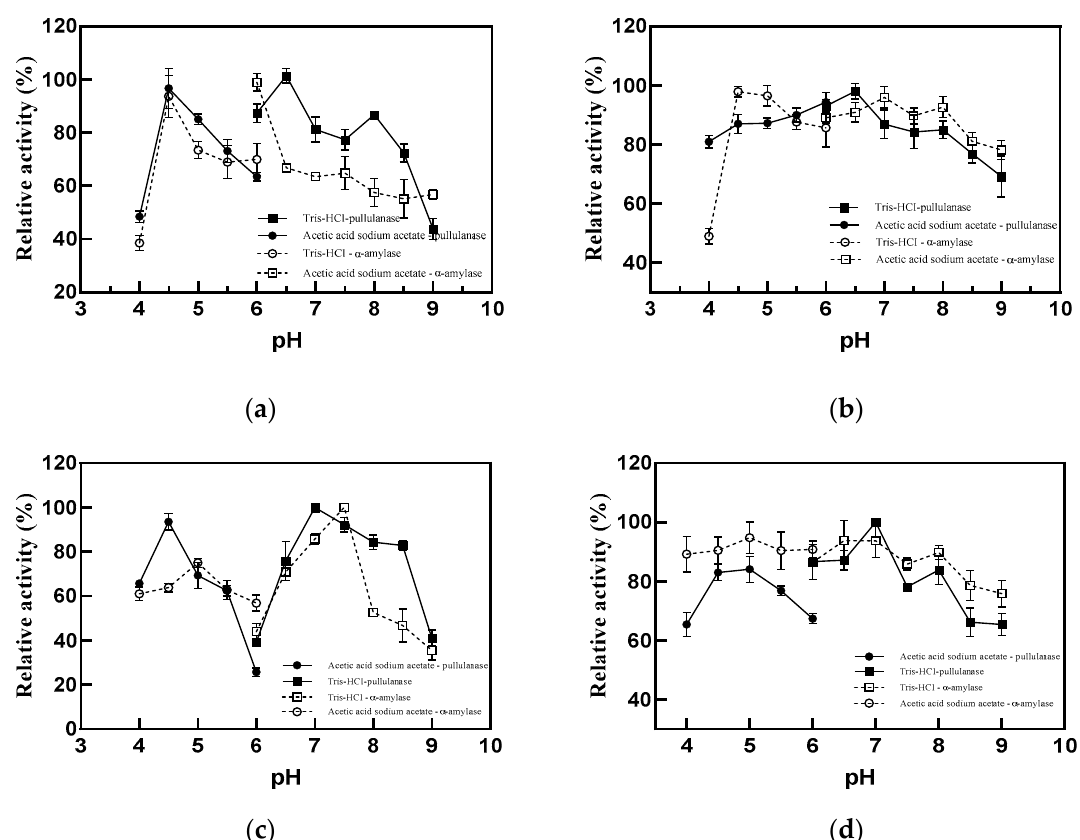
Figure 4. pH properties of Pul-HJ21 and Pul-HJ Δ 782. ( a ) Optimal pH of Pul-HJ21; ( b ) optimal pH of Pul-HJ Δ 782; ( c ) pH stability of Pul-HJ21; ( d ) pH stability of Pul-HJ Δ 782.